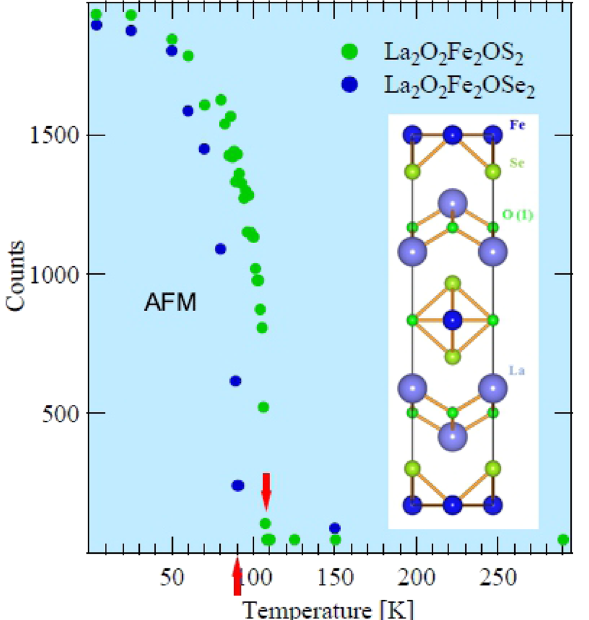
Fig. 1 The magnetic order parameter of La 2 O 2 Fe 2 O(S, Se) 2 . The intensity of an antiferrommagnetic peak (103) in La 2 O 2 Fe 2 O(S, Se) 2 as a function of temperature. At room temperature La 2 O 2 Fe 2 O(S, Se) 2 are in the paramagnetic phase. The development of magnetic ordering is observed for both materials as the temperature decreases. The Neel temperatures T N , indicated by the arrows, for M = S and Se are 107.2(6) ± 0.06 K and 90.1(9) ± 0.16 K, respectively. The inset shows the crystal structure of La 2 O 2 Fe 2 OSe 2 .